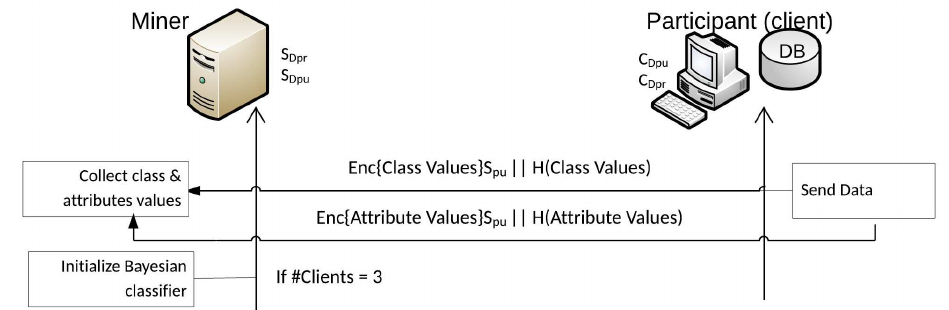
Figure 5. Classifier initialization phase. Phase 5: TAN classifier creation.